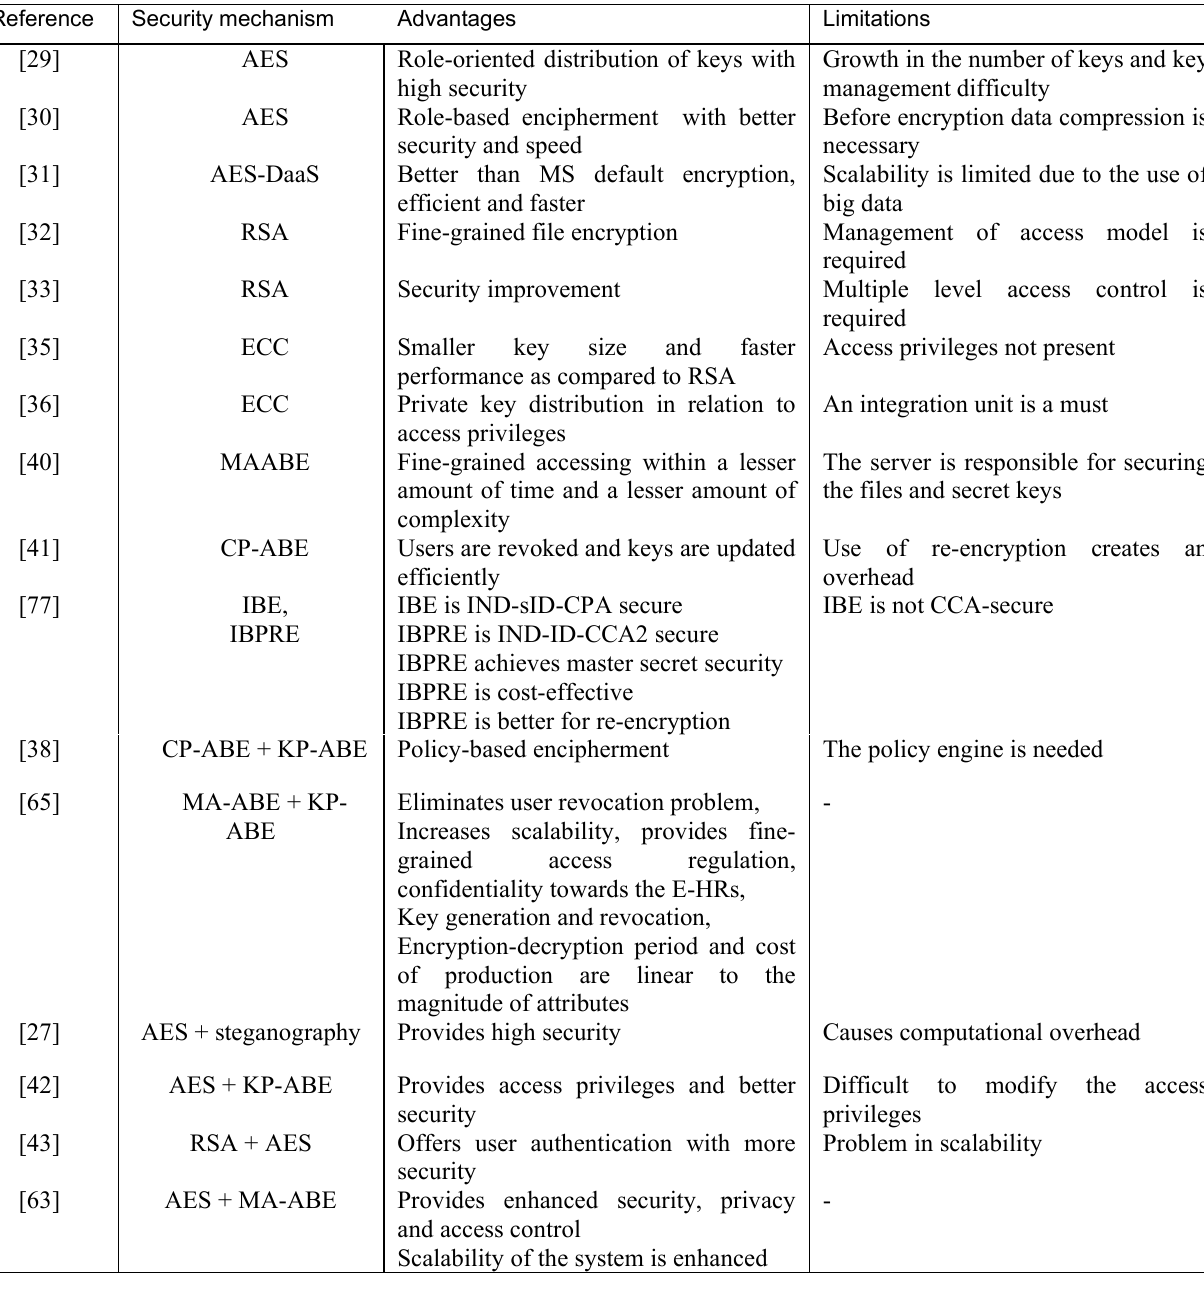
Table (4.a). The advantages and limitations of the crypto security